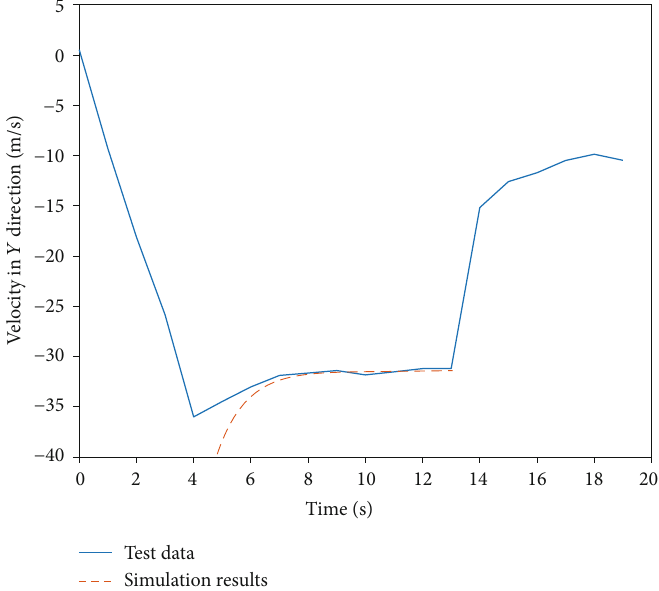
Figure 15: Velocity of test parachute in Y